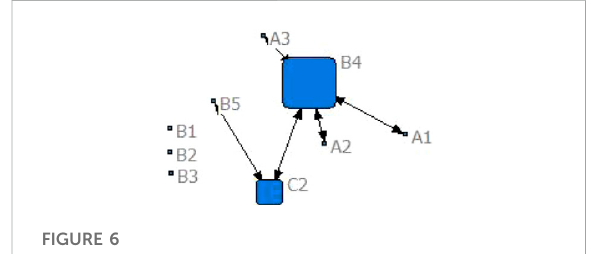
FIGURE 6 Network structure diagram after removing the C1 node.